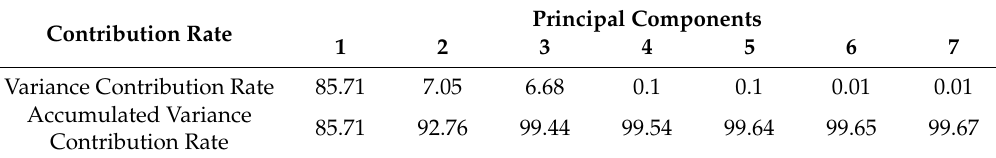
Figure 6. First ten components of PWV and T in southeast China from 1979 to 2017 using multichannel singular spectral analysis (MSSA). Table 2. Contribution rates corresponding to the first seven eigenvalues in Southeastern China from 1979 to 2017.